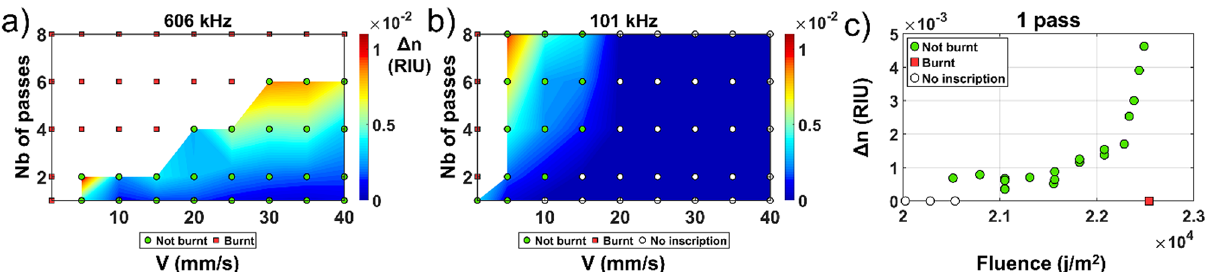
Figure 4. Fs laser induced refractive index change in PDMS-Bp for various writing speed and numbers of passes at ( a ) 606 kHz and ( b ) 101 kHz. ( c ) Refractive index change evolution relative to the fluence for one pass by varying the writing speed and/or the repetition rate